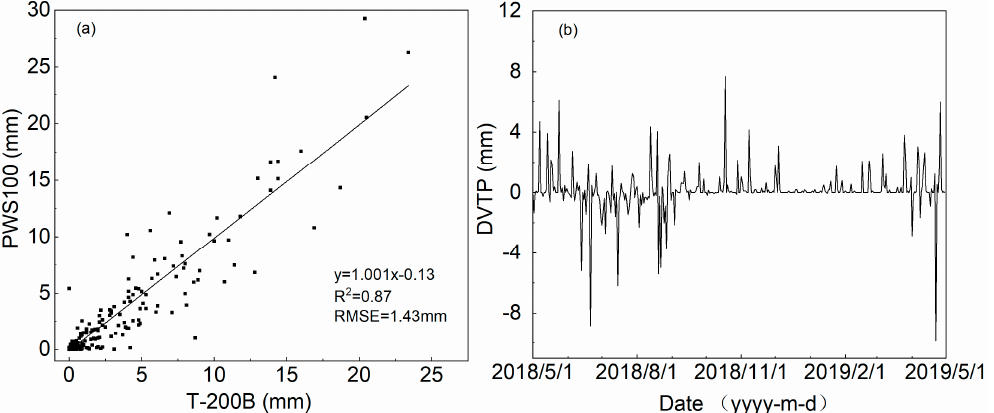
Figure 2. Correlation between daily precipitation amounts collected by Geonor T-200B and PWS100 ( a ); the variation of difference value of precipitation amount recorded by Geonor T-200B and PWS100